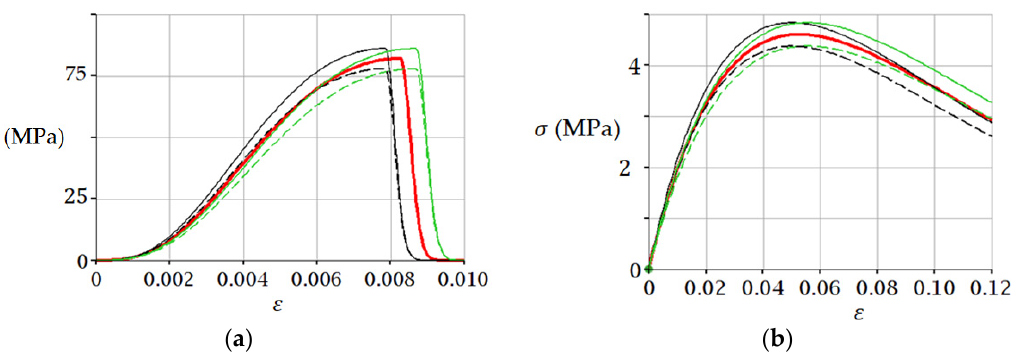
Figure 8. Effect of deviations in σ peak , ε peak on uniaxial compression behavior of samples: ( a ) Sandstone from example 1; ( b ) Frozen sand from example 2. The red line corresponds to the parameters σ peak , ε peak . Thin lines correspond to parameters with deviations: σ peak · ( 1 ± 0.05 ) , ε peak · ( 1 ± 0.05 ) . The red curve simulates the experimental curve from [36] ( a ) and [56] ( b ).